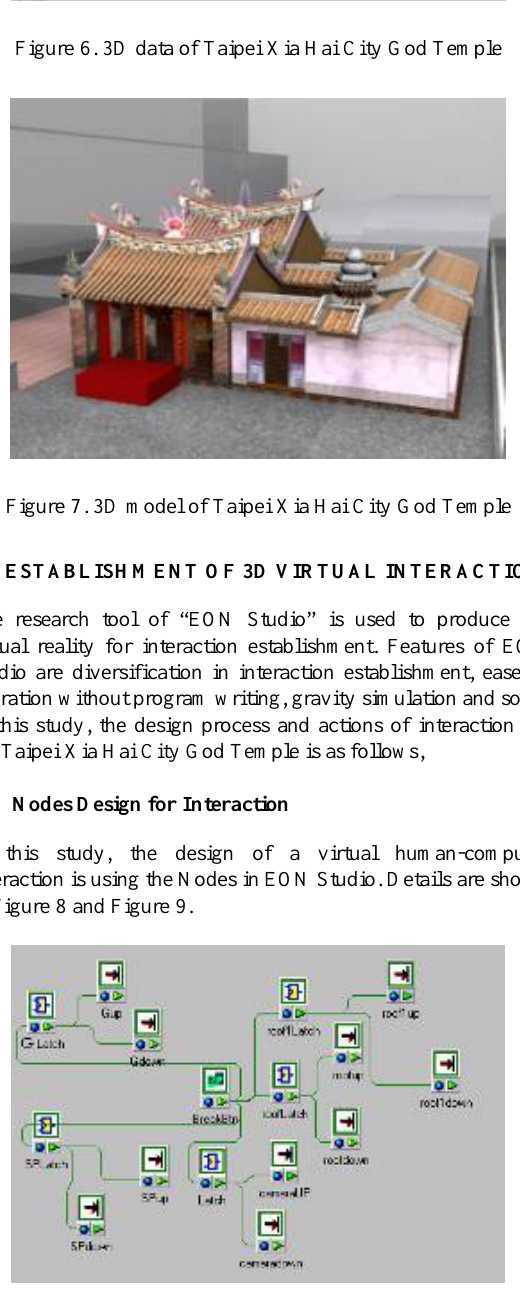
Figure 8. Actions of interaction for the Taipei Xia Hai City